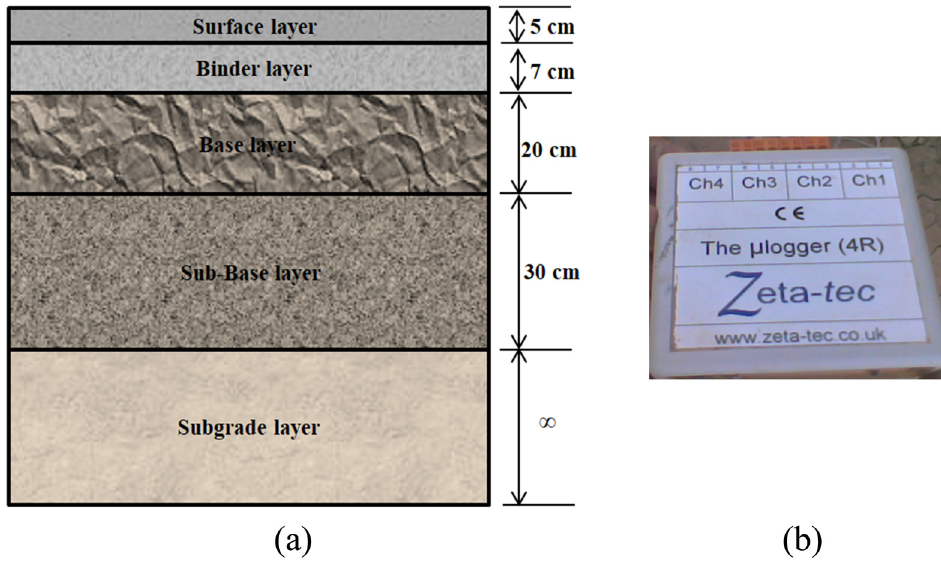
Figure 1: ( a ) Pavement structure layers. ( b ) Data logger device.